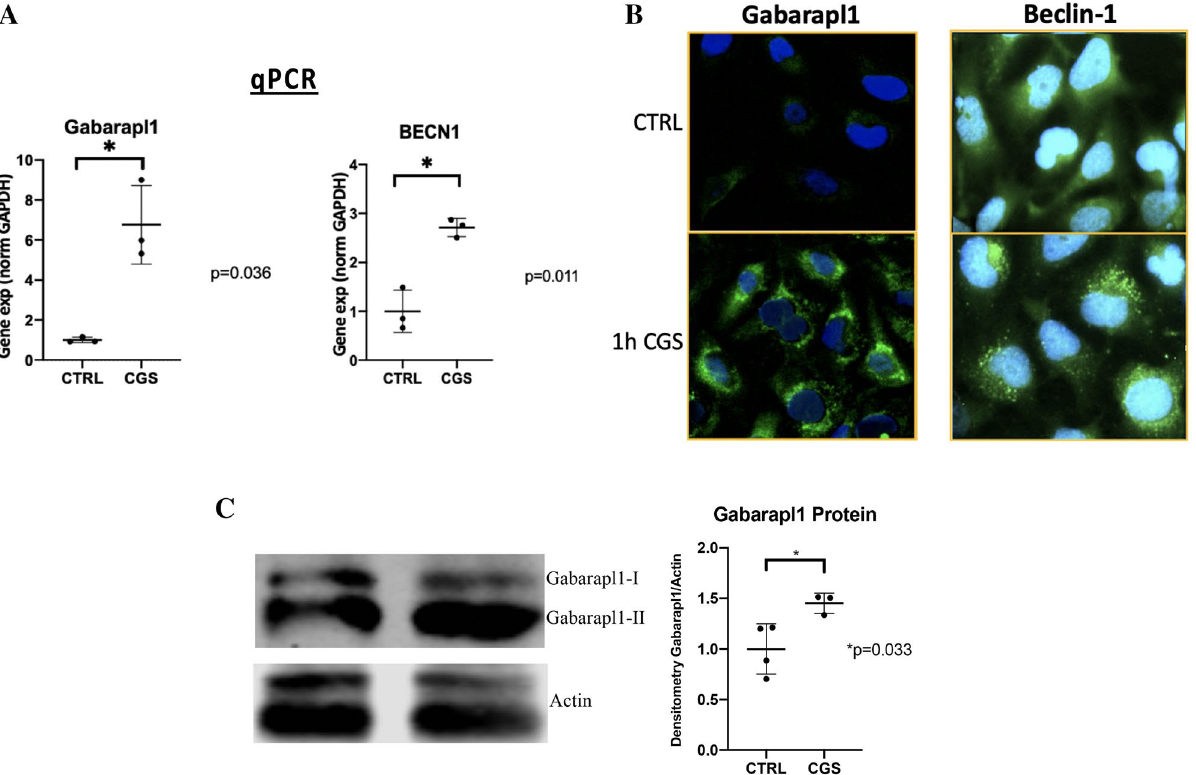
Figure 3. FoxO-activated autophagy mediators Gabarapl1, and Beclin-1 were activated in response to A2AR signaling. TC28 ⍺ 2 human chondrocytes were treated with 1 µM CGS (Gabarapl1-assessed cells were incubated with HCQ overnight to enhance autophagosome visualization). ( A ) RNA was isolated from cells and Gabarapl1 and Beclin-1 gene expression were assessed. ( B ) Autophagy proteins were visualized by IF in TC28 ⍺ 2 human chondrocytes specifically for Gabarapl1 (left) and Beclin-1 (right) shown as untreated (CTRL) or 1 h of CGS. Both proteins are demonstrated by green fluorescence. Development of punctate autophagy initiation complexes can be observed after 1 h. These are 40 × hpf views of representative cells repeated in 3 separate experiments. ( C ) Western blot for Gabarapl1 protein levels in total cellular lysates from TC28a2 cells treated ±